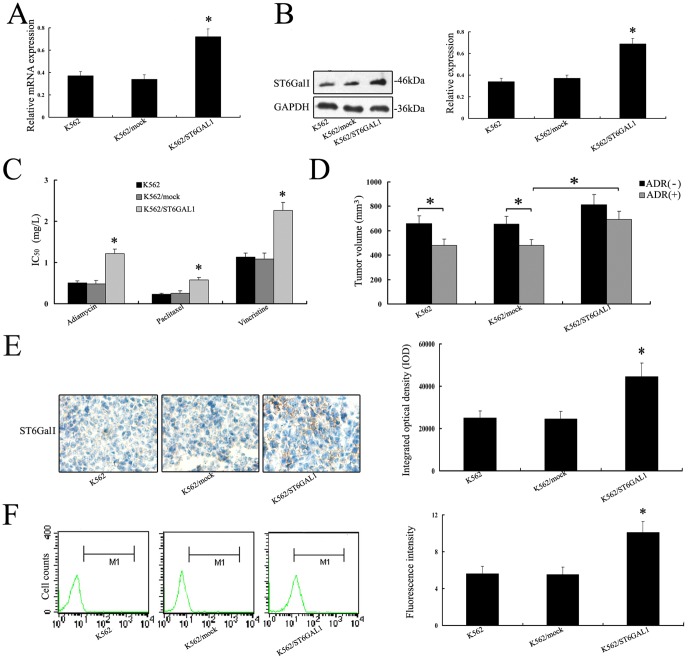
Overexpression of ST6GAL1 gene enhances the chemoresistance of K562 cells both in vitro and in vivo.After transfection, ST6GAL1 mRNA (A) and protein (B) were increased notably in K562 cells by real time PCR and western blot. (C) Cell chemosensitivity was assessed by cytotoxicity assays. The reported values are the IC50 (Mean ± SD) of three independent experiments. IC50 represents the drug concentration producing 50% decrease of cell growth. *P<0.05 vs K562/mock cells. (D) An increase of mean tumor in mice group with K562/ST6GAL1 was observed, as compared with that in K562 group and K562/mock group. Within K562/ST6GAL1 group, an increase of tumor growth was found in group without ADR, compared with that with ADR (*P<0.05). (E) Up-regulation of ST6GAL1 was also shown by IHC staining in xenograft tumors derived from K562/ST6GAL1 cells (400×). (F) Increased expression of ST6GAL1 was detected by flow cytometry analysis in K562/ST6GAL1 cells. The data are means ± SD of 3 independent assays (*P<0.05).